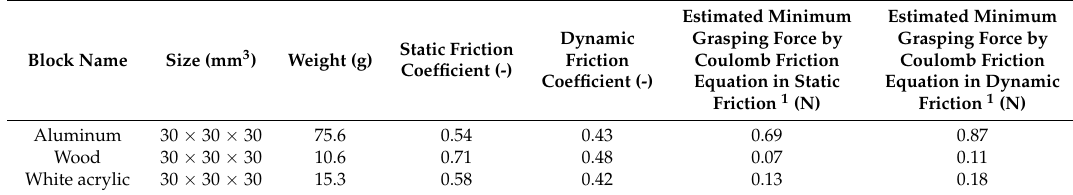
Table 1. Specifications of target